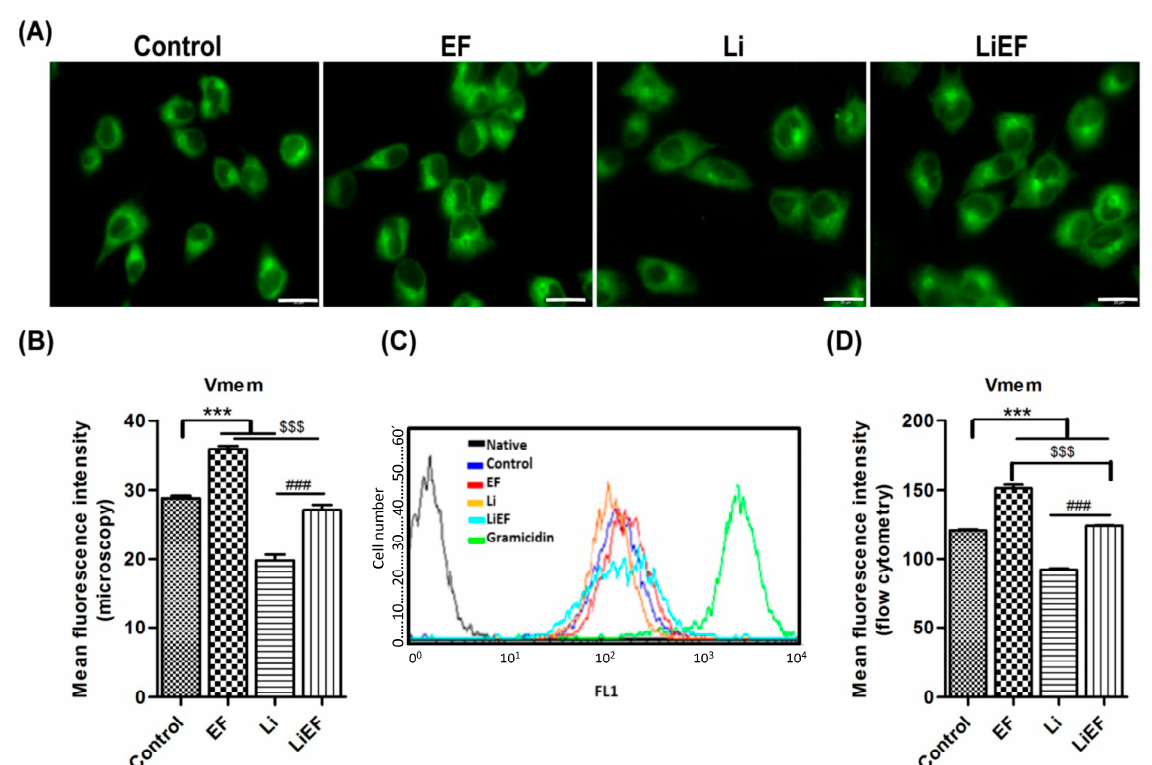
Figure 2. EF depolarizes plasma membrane potential in irradiated 661W cells. EF induced membrane depolarization was determined by an anionic fluorescent dye DiBAC 4 (3). ( A ) Representative images of the fluorescence intensity of cells imaged using fluorescence microscope in all treated samples at 0 h. Increased fluorescence intensity was observed in EF stimulated cells and a decreased fluorescence intensity in Li-treated cells compared to control cells. (Scale bar = 20 µm). ( B ) Quantitative analysis of fluorescence intensity of the dye in all samples measured at fluorescence microscope. ( C ) Histogram representing mean DiBAC 4 (3) fluorescence intensity profile obtained from flow cytometry at 0 h of different samples is shown as FL1 on x -axis. Gramicidin-treated cells were used as a positive control. ( D ) Quantitative analysis of fluorescence intensity of the dye measured using flow cytometry at different treated conditions: Control, EF, Li, and LiEF (number of cells in triplicates = 40 (microscopy); 5000 (flow cytometry); 3 independent experiments; mean ± S.E.M; *** p < 0.001 w.r.t control; $$$ p < 0.001 w.r.t EF; ### p < 0.001 w.r.t Li; One way-ANOVA followed by